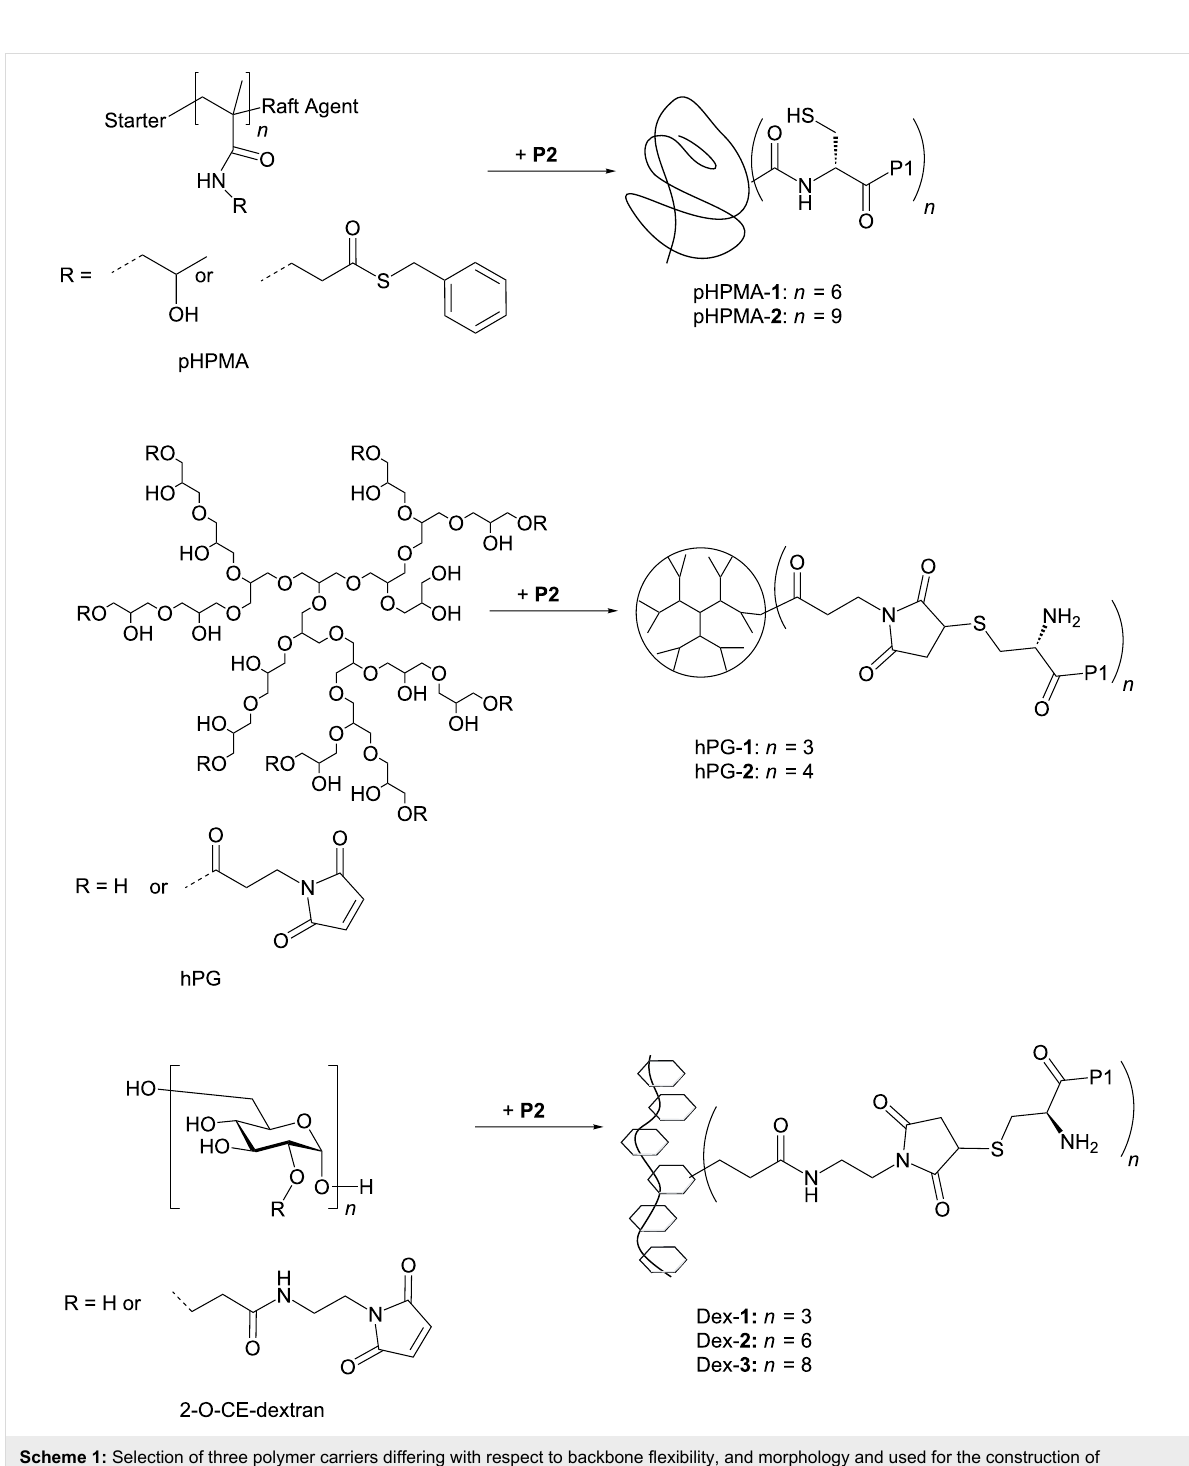
Scheme 1: Selection of three polymer carriers differing with respect to backbone flexibility, and morphology and used for the construction of peptide–polymer conjugates.